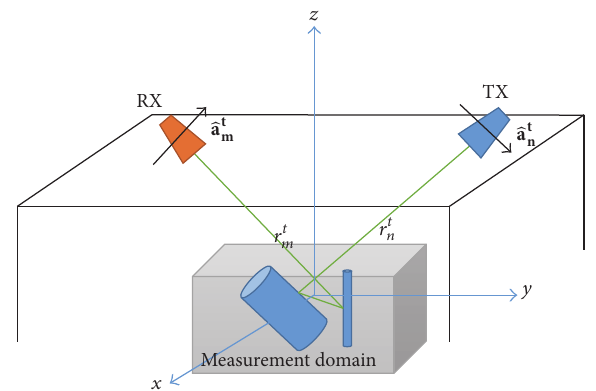
Figure 2: 3D model of the target of